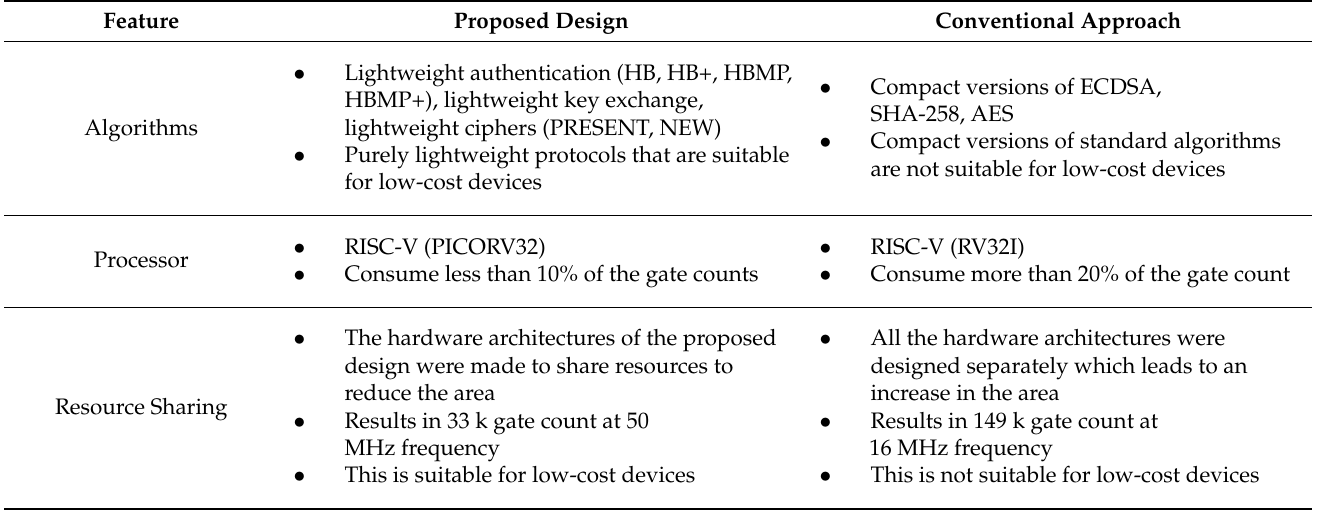
Table 5. Features of the SoC-based lightweight cryptographic